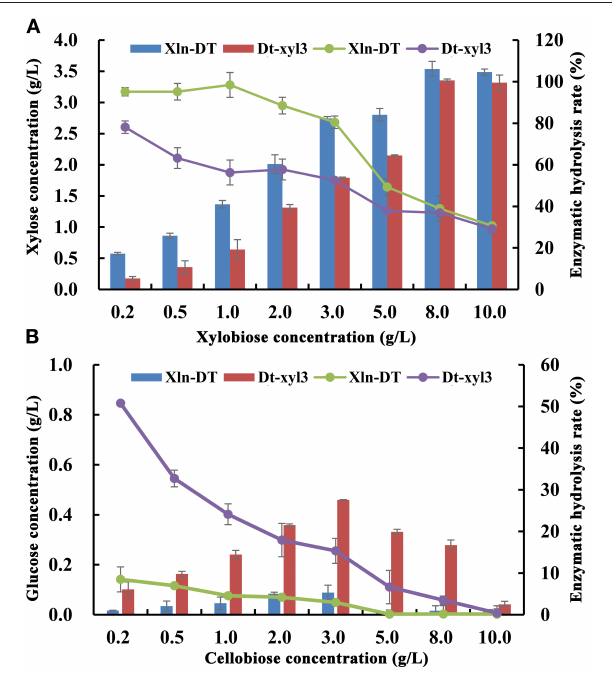
FIGURE 3 | Analysis of xylobiose and cellobiose hydrolyzed by recombinant β -xylosidase Xln-DT and Dt-xyl3 [ (A) Xylobiose; (B) Cellobiose; column: xylose/glucose concentration; line: enzymatic hydrolysis